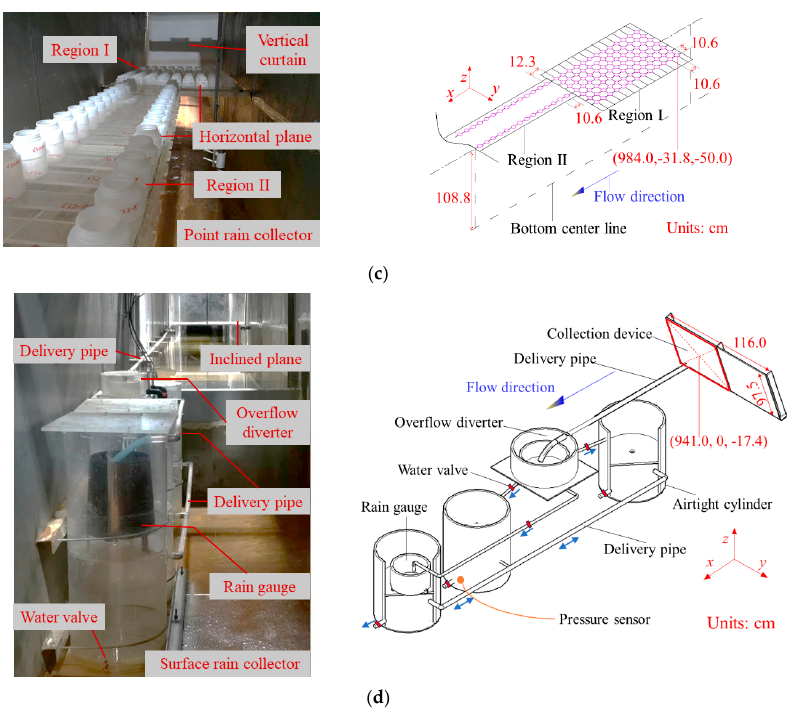
Figure 2. Physical diagram and partial design of the experimental platform. ( a ) Depressurized chamber layout; ( b ) Constricted nozzle layout; ( c ) Point rain collection and measurement device of the horizontal plane; ( d ) Surface rain collection and measurement device of the inclined plane.